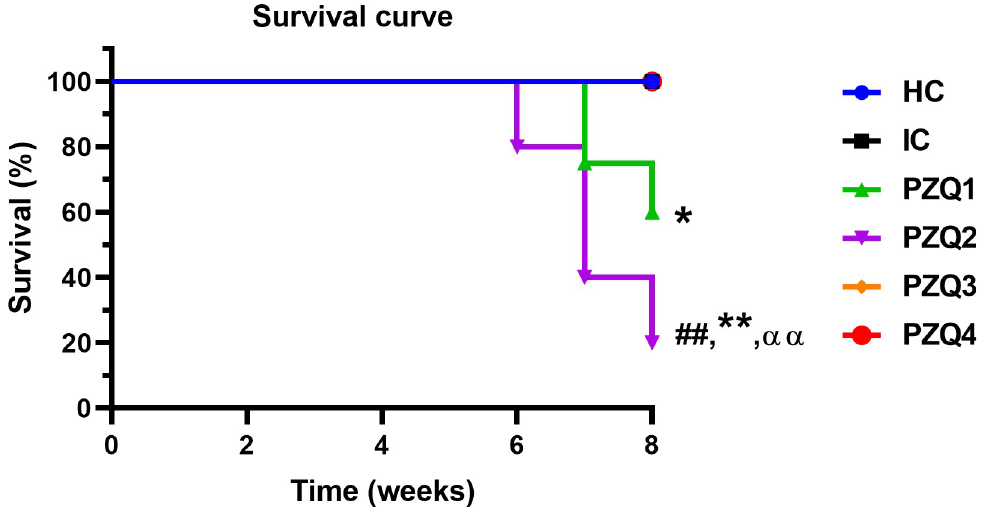
Fig 1. Survival curve of mice infected with Schistosoma mansoni and treated with different praziquantel regimens. HC: Uninfected-untreated mice, IC: Infected-untreated mice, PZQ1: Infected mice treated with praziquantel at 100 mg/kg for 5 consecutive days, PZQ2: Infected mice treated with praziquantel at 100 mg/kg for 28 consecutive days, PZQ3: Infected mice treated with praziquantel at 18 mg/kg for 28 consecutive days, PZQ4: Infected mice treated with a single dose of praziquantel at 500 mg/kg. ANOVA followed by Tukey multiple comparison test was also used for statistical analysis. ## p < 0.01: values are significantly different from those of uninfected mice (group HC). � p < 0.05, �� p < 0.01: values are significantly different from those of infected-untreated mice (group IC). αα p < 0.01: values are significantly different from those of infected mice treated with PZQ3 posology (group PZQ3).